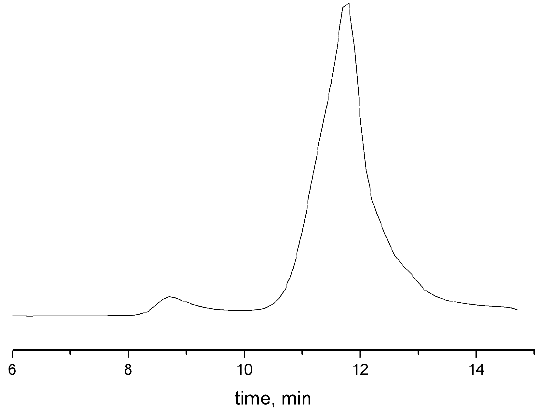
Figure 3. Eluogram for APE O -g-PiPrOx sample obtained after grafting at 1/40 initiator/monomer ratio.